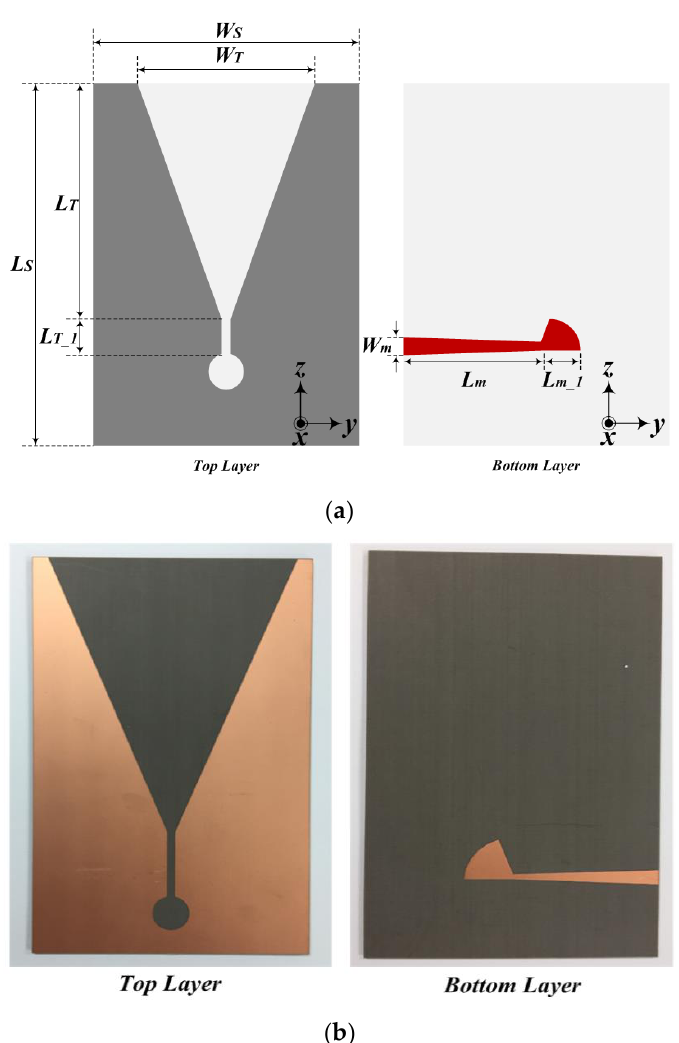
Figure 2. Configuration of the proposed tapered slot antenna: ( a ) geometry and ( b ) photograph of antenna.